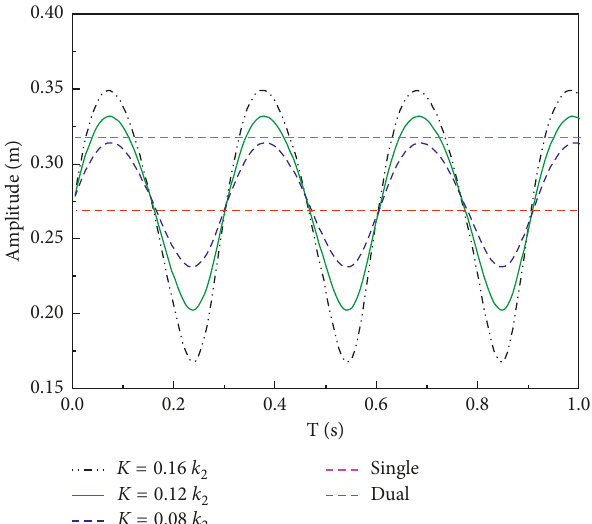
Figure 6: Variation of angle frequency with time-delay parameter T under different strength parameters K 1 with time-delay